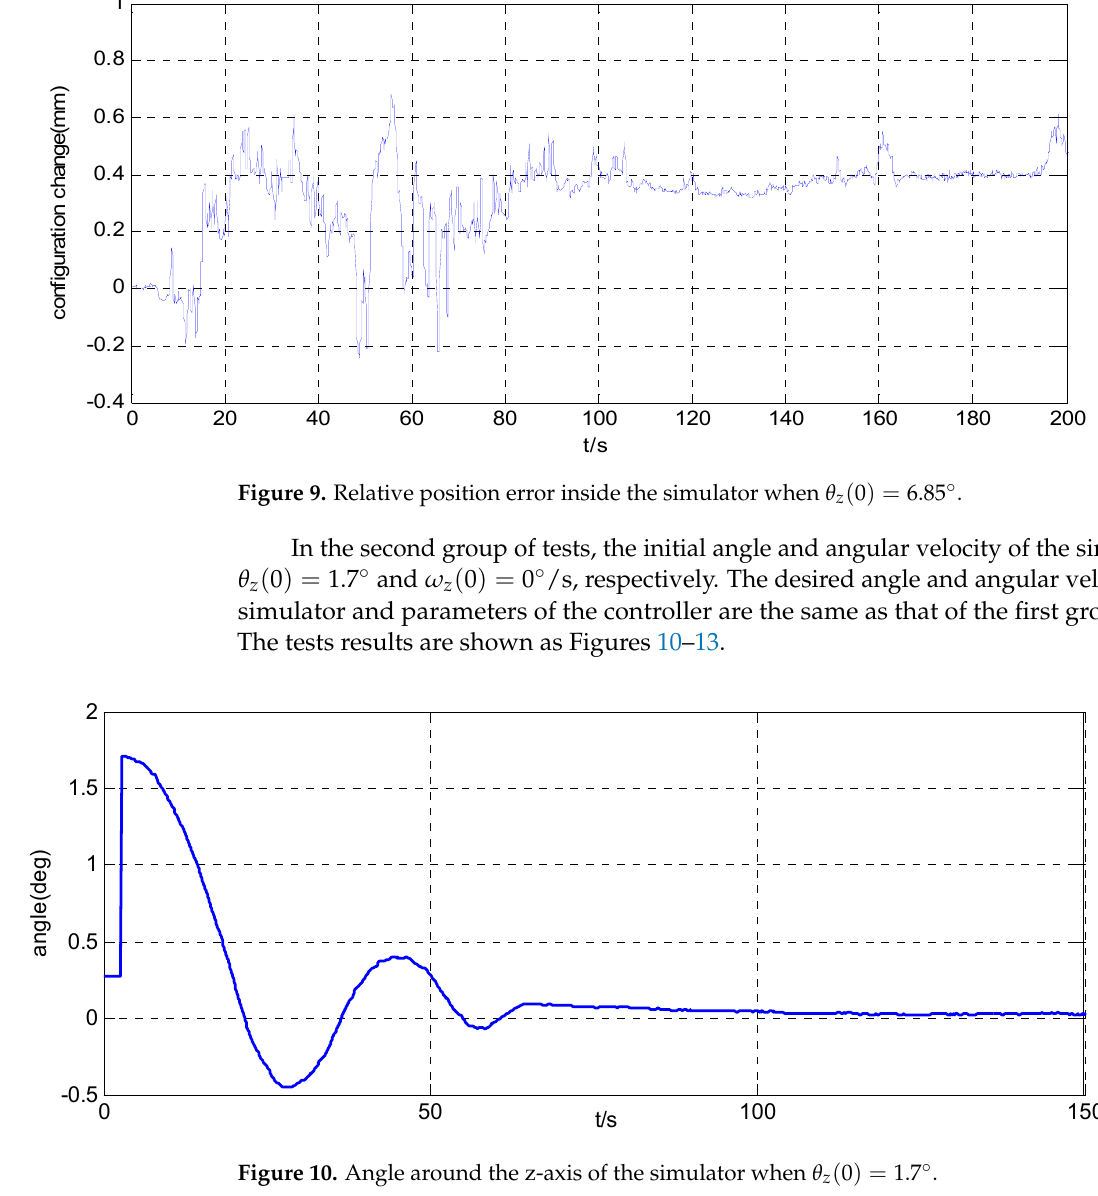
Figure 11. Angular velocity around the z-axis of the simulator when  . Figure 12. Relative angle error inside the simulator when